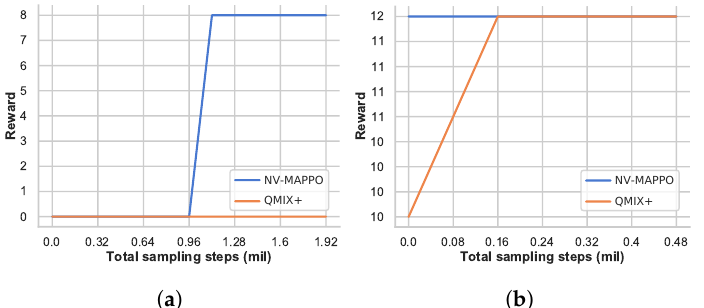
Figure 4. The test returns for NV-MAPPO and QMIX in two kinds of non-monotonic Matrix Games. ( a ) Learning results for Matrix Game 1; ( b ) learning results for Matrix Game 2. Next, we compared the performance of MAPG and MAPPO with their noisy